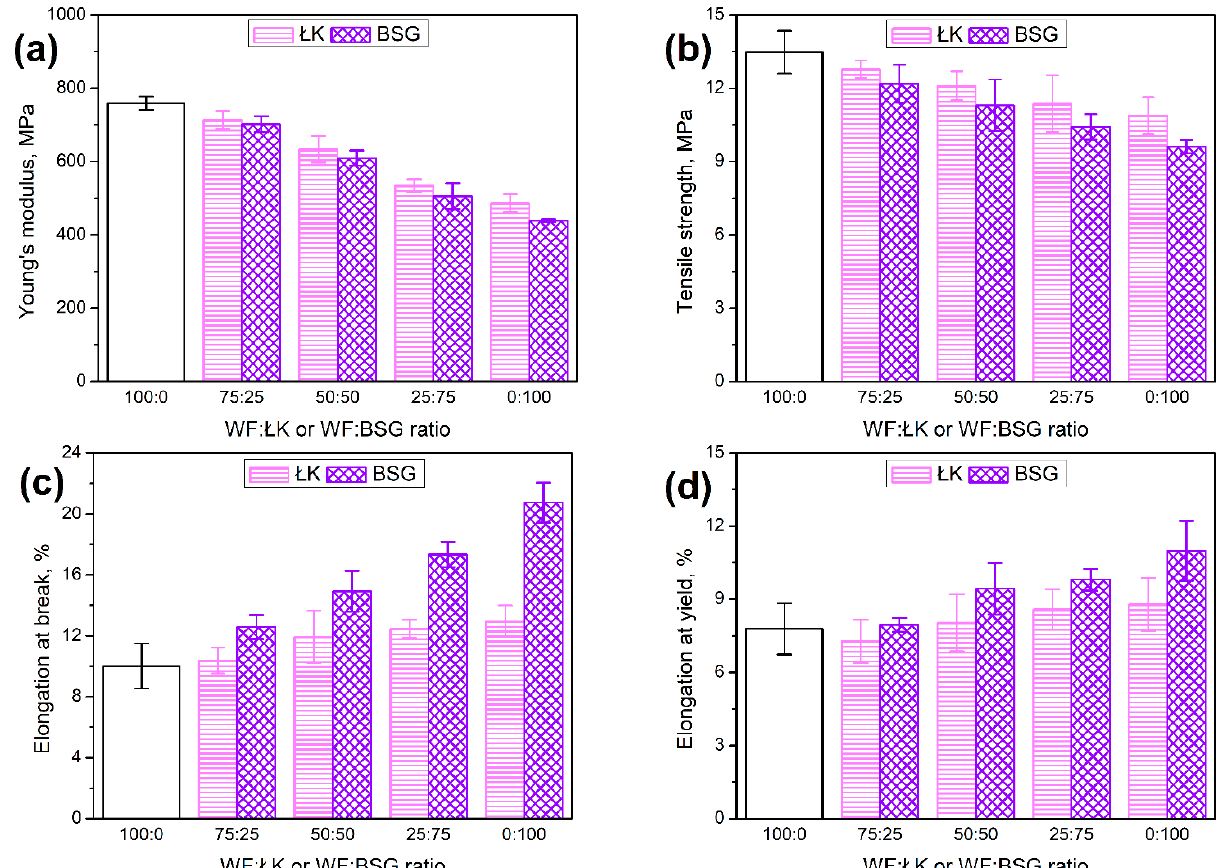
Figure 7. The effect of WF substitution with ŁK and BSG on the ( a ) Young’s modulus, ( b ) tensile strength, ( c ) elongation at break, and ( d ) elongation at yield of prepared composites.